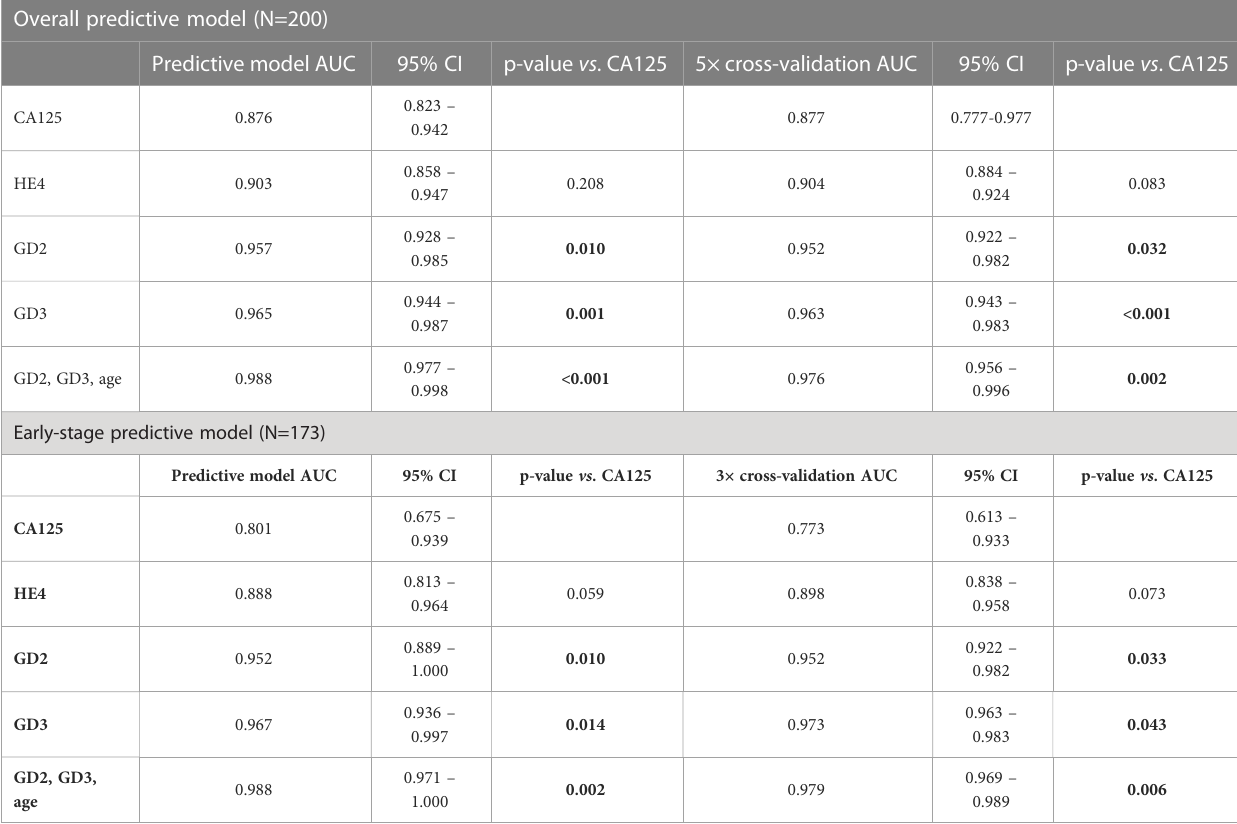
TABLE 2 Summary and statistics of ELISA analysis — diagnostic model and cross-validation. Overall predictive model (N=200)